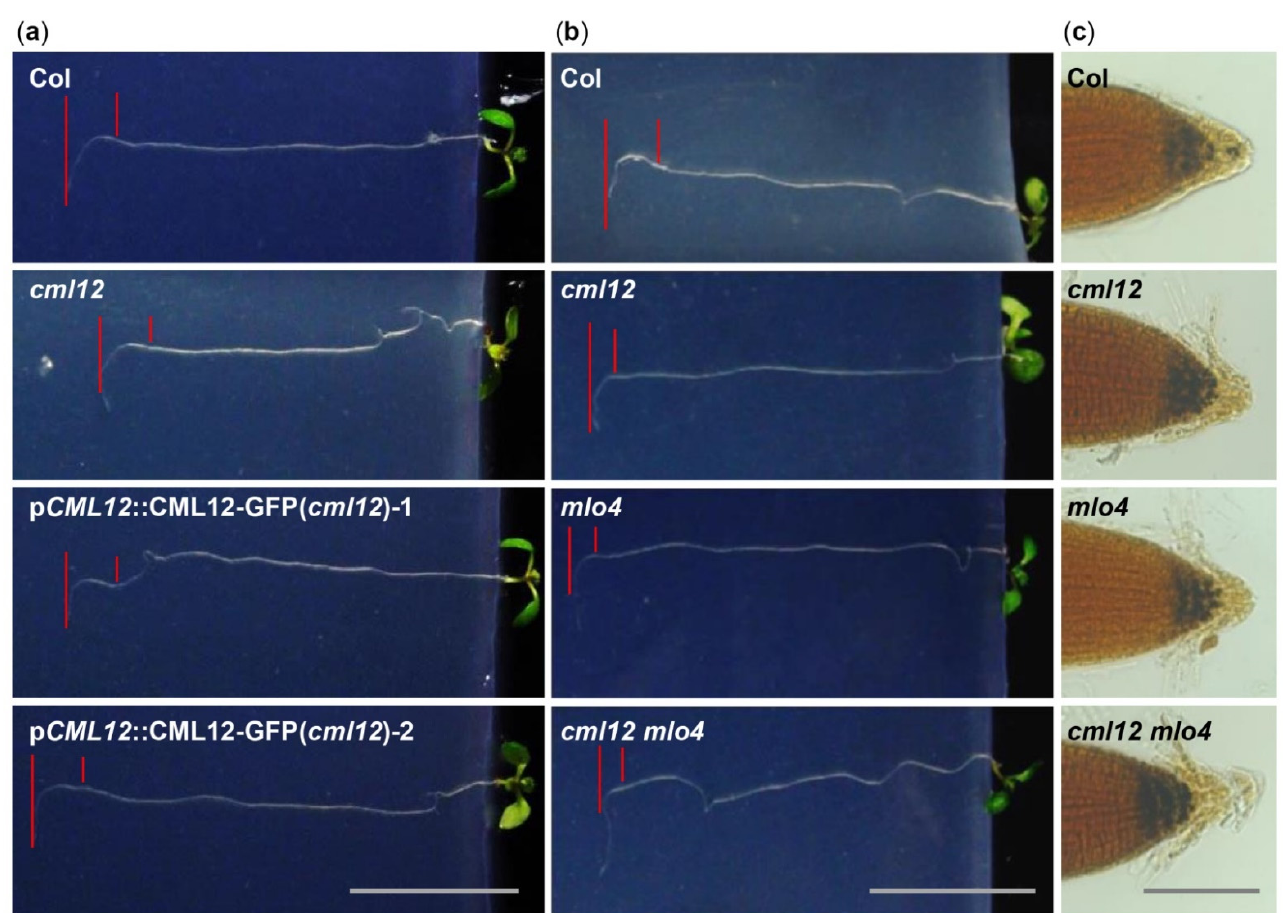
Figure 4. Phenotype analysis of cml12-3 and mlo4-5 mutants. cml12-3 and mlo4-5 mutants were indicated, respectively, as cml12 and mlo4, for short. ( a ) 7-day-old seedlings growing through the agar medium were rotated by 90° in the clockwise direction. ( b ) Roots bent down to respond to gravity change. Red lines point to tip position at the time of rotation and the location where root growth became parallel with new gravity vector. Bar = 1 cm. ( c ) Starch was detected using KI-I 2 stain Starch in single mutants cml12-3 and mlo4-5 and double mutant cml12-3 mlo4-5 was obviously more than that in wild-type root tips. Bar = 100 μ m.